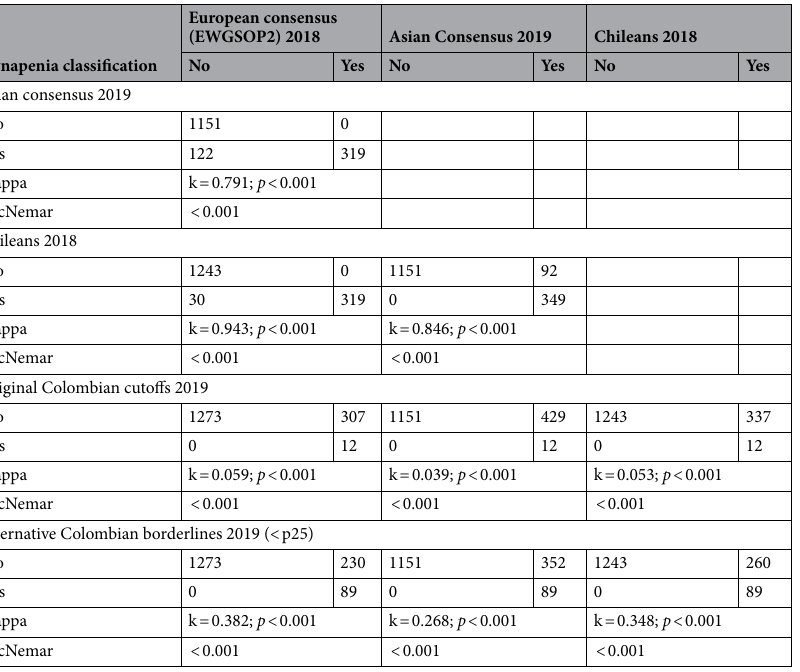
Table 4. Concordance between different cutoff points for dynapenia. European consensus EWGSOP2 2018: European Working Group on Sarcopenia in Older People update in 2018 5 . Asian consensus 2019 11 . Chileans 2018: Reference values of handgrip dynamometry in older Chileans 13 . Original Colombian cutoffs 2019: reference cutoffs for handgrip strength among older adults 17 . Alternative Colombian borderlines 2019 (< p25): values lower than the 25-percentile taken from Ramirez-Velez et al. 17 . K: Cohen’s Kappa Coefficient. McNemar: McNemar test. < p25: Values below 25